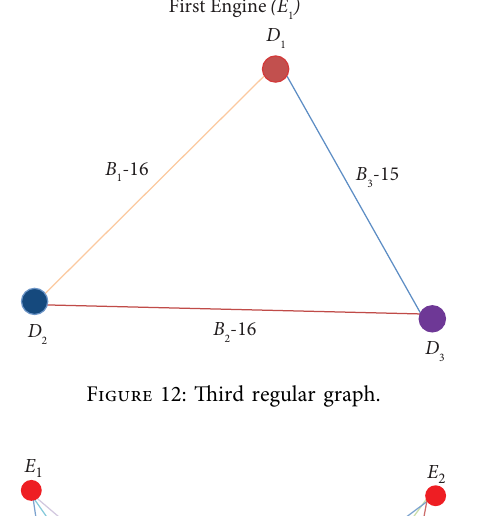
Figure 12: Tird regular graph.